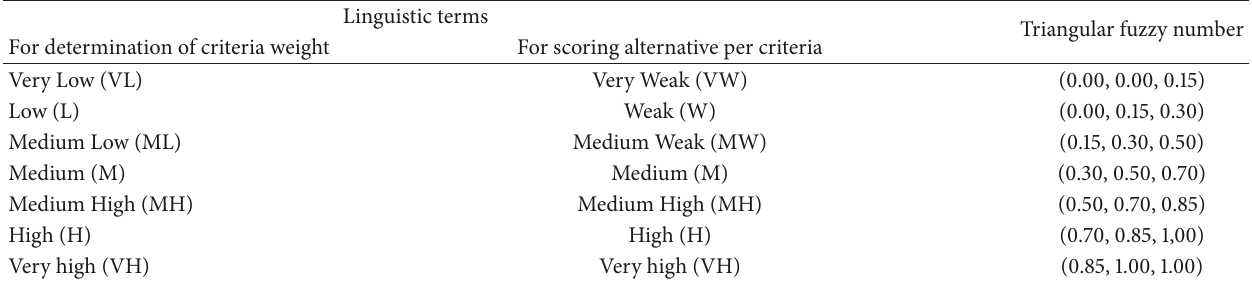
Table 1: Linguistic terms and corresponding fuzzy numbers. Linguistic terms